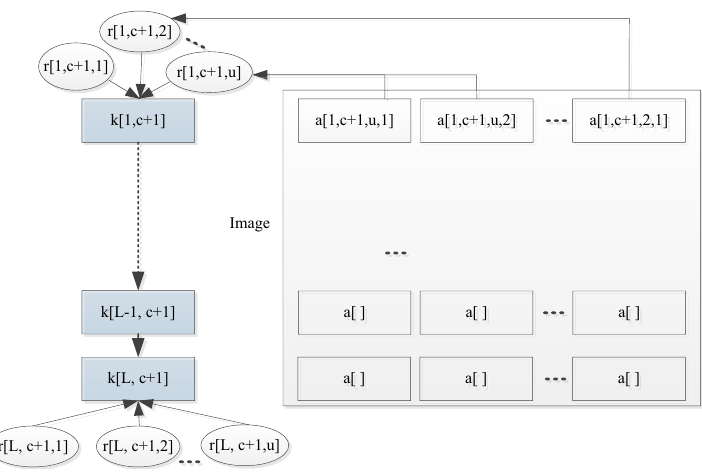
Figure 4. Hierarchical key-role-area access control model ( HKRAGraph